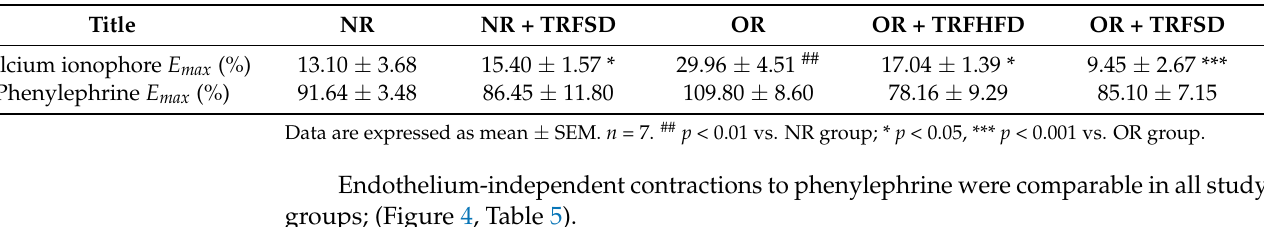
Figure 4. Endothelium-dependent and endothelium-independent contractions in the thoracic aorta of rats. ( A ) Concentration-response curves to calcium ionophore (10 − 9 − 10 − 5 M); ( B ) Concentration- response curves to phenylephrine (10 − 9 –10 − 4 M). Data are presented as mean ± SEM ( n = 7). ## p < 0.01 vs. NR. ** p < 0.05 and *** p < 0.001 vs. OR. Table 5. Contractions to calcium ionophore and phenylephrine in the thoracic